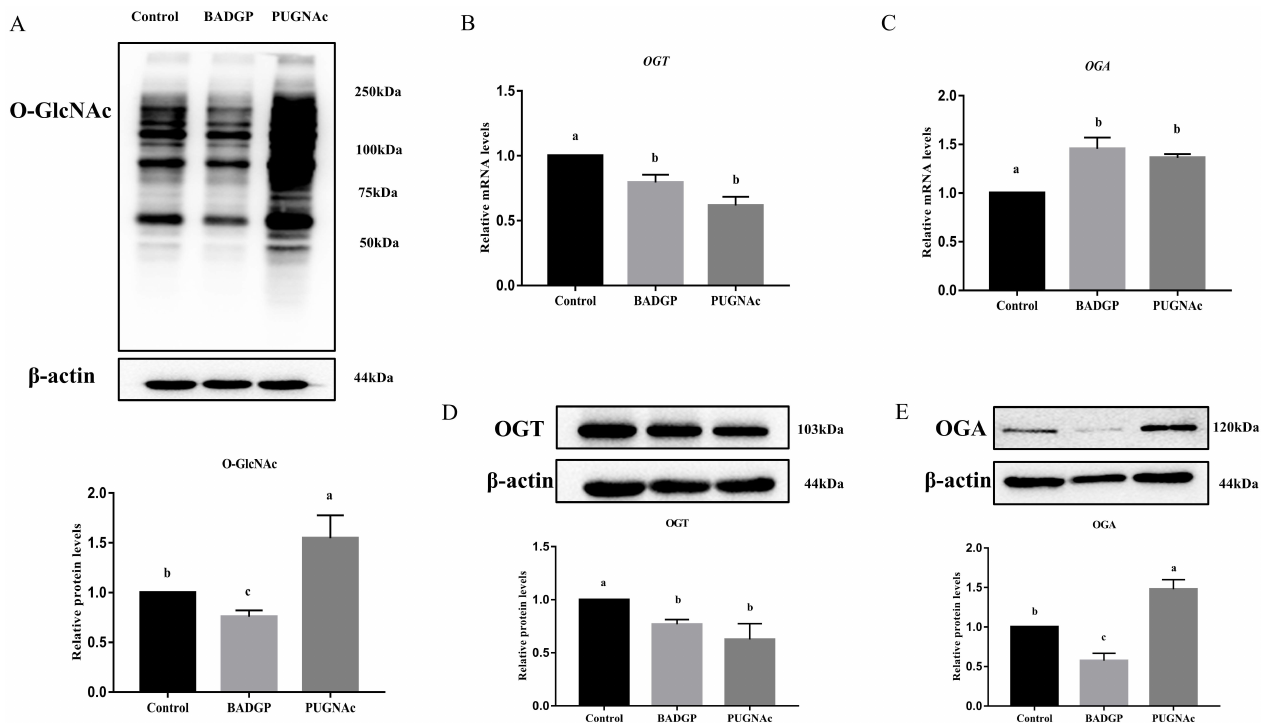
Figure 1. Alteration of O-GlcNAc levels affects the expression of OGT and OGA in bovine granulosa cells. ( A ) Immunoblot of overall O-GlcNAc levels, and the chart below shows the relative amounts of proteins. ( B ) OGT mRNA levels. ( C ) OGA mRNA levels. ( D ) Immunoblot of OGT levels, and the chart below shows the relative amounts of proteins. ( E ) Immunoblot of OGA levels, and the chart below shows the relative amounts of proteins. Values are mean ± SEM of at least three